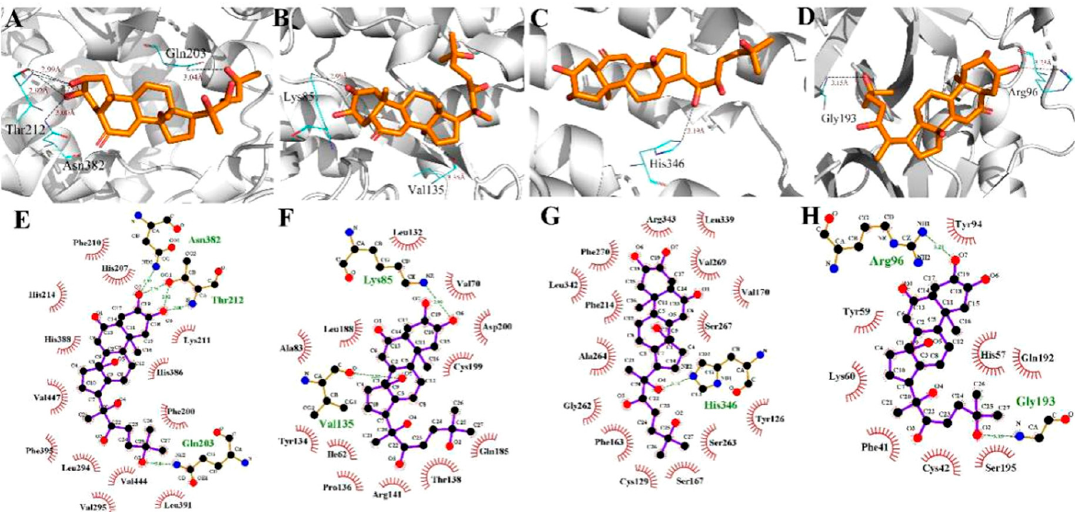
Figure 6. Detailed view of the binding interaction between Ecdysterone and four representative receptors. ( A,E ) F2-Prothrombin. ( B,F ) GSK3B-Glycogen synthase kinase-3 beta. ( C,G ) IDO1-Indoleamine 2,3-dioxygenase. ( D , H ) PRSS1-Trypsin-1.